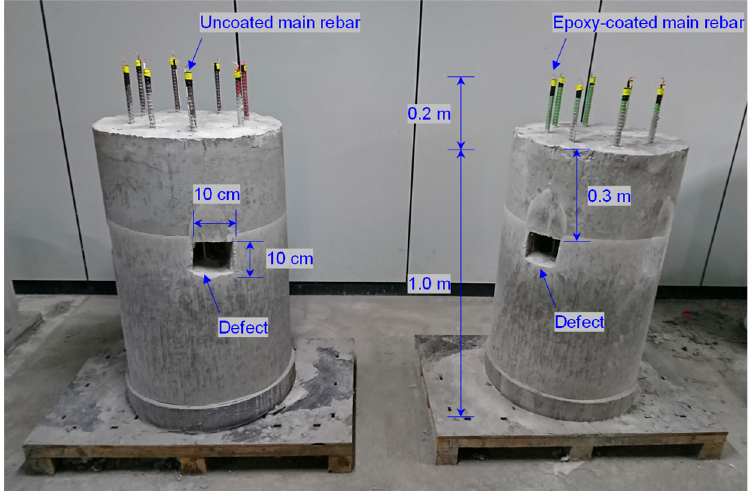
Figure 4. Small-scale model piles constructed with an uncoated reinforcement cage ( left ) and with an epoxy-coated reinforcement cage ( right ).